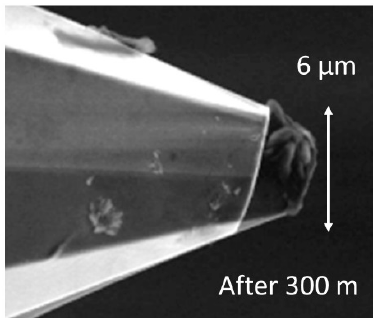
Figure 19. SEM image of a microprobe tip after measurements at a length of 300 meters on a roughness standard and overlaid image of the tip after 2 meters of wear length.